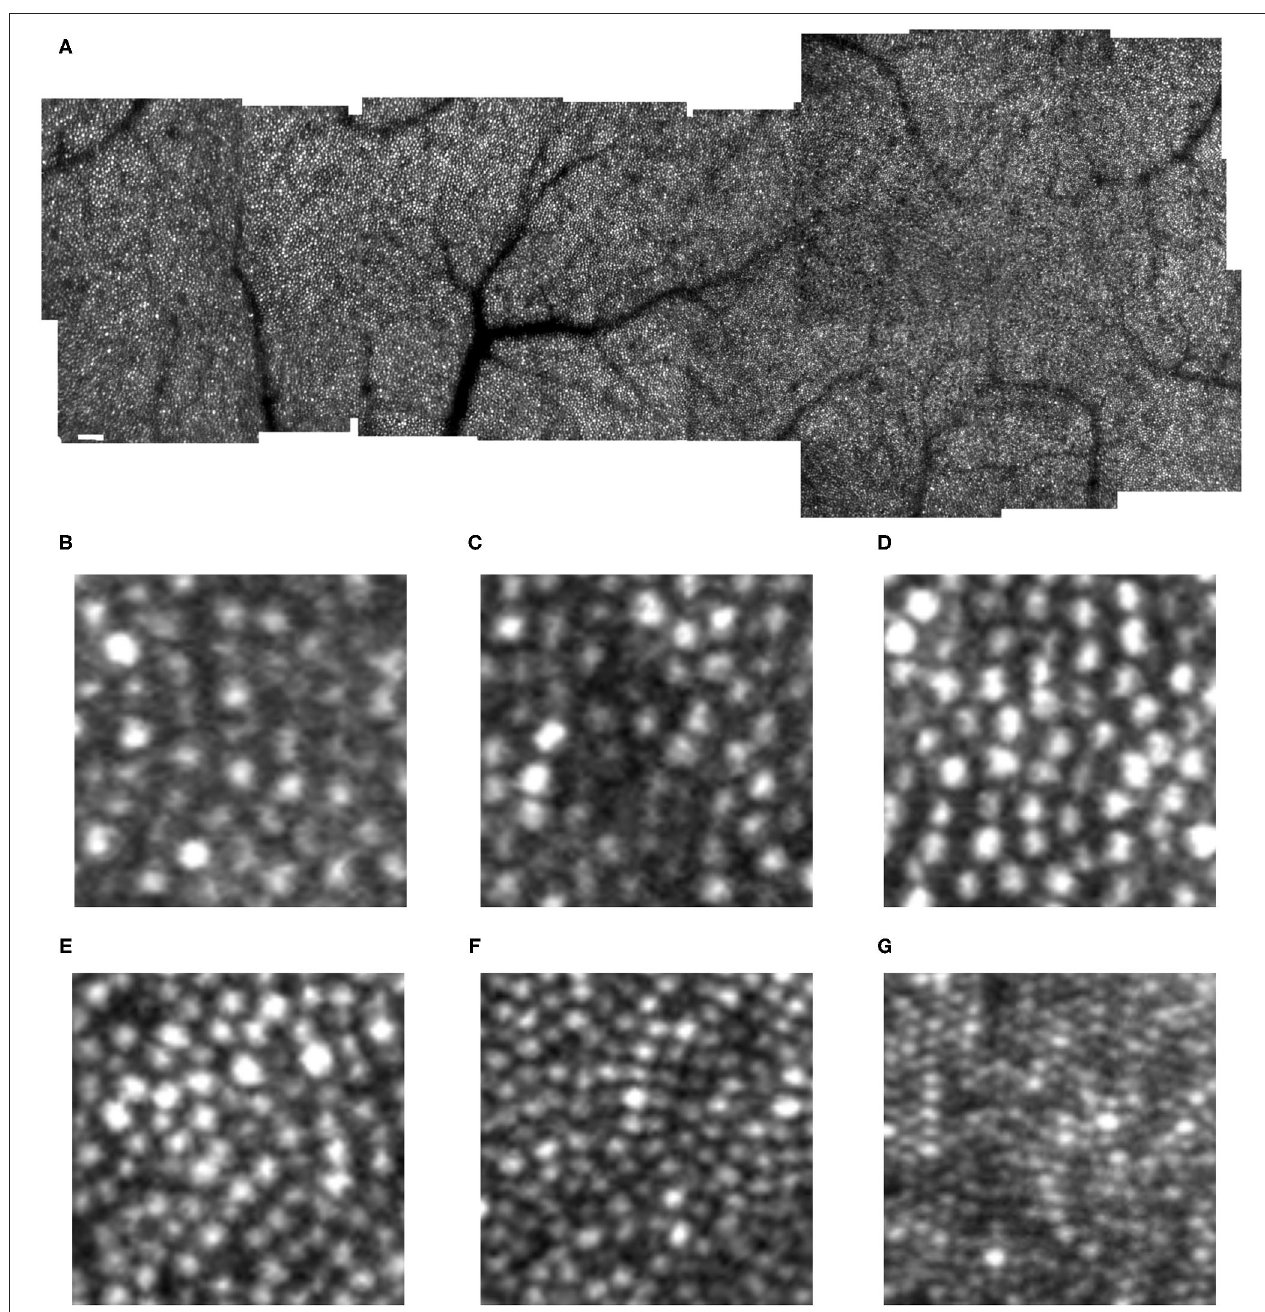
FIGURE 1 | Cone distribution for a 25 yr old female control subject, shown in a montage of individual images (A) of the right eye collected with the confocal mode of the AOSLO. The fovea, which is on the right, has the highest cone density. There is smoothly decreasing cone density farther from the fovea, with the temporal meridian shown. Small white scale bar at lower left = 100 microns. (B–F) Individual cones shown at increased magnification in regions of 100 × 100 microns with the upper far corner at 8.7 (B) , 8.4 (C) , 7.0 (D) , 4.8 (E) , 2.8 (F) temporal and 1.1 deg temporal inferior (G) deg temporal with respect to the fovea.